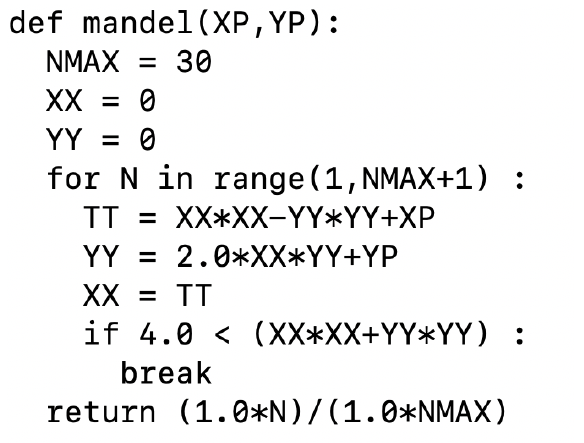
Figure 5. gopaw mandel.py Python script Figure 3. ROOT style